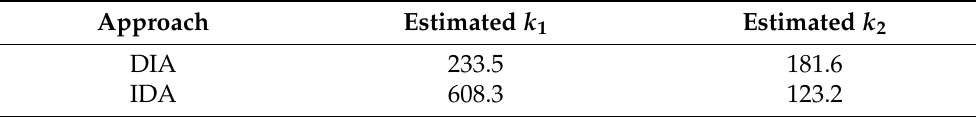
Table 2. Comparison of stiffness identification in the vibrating